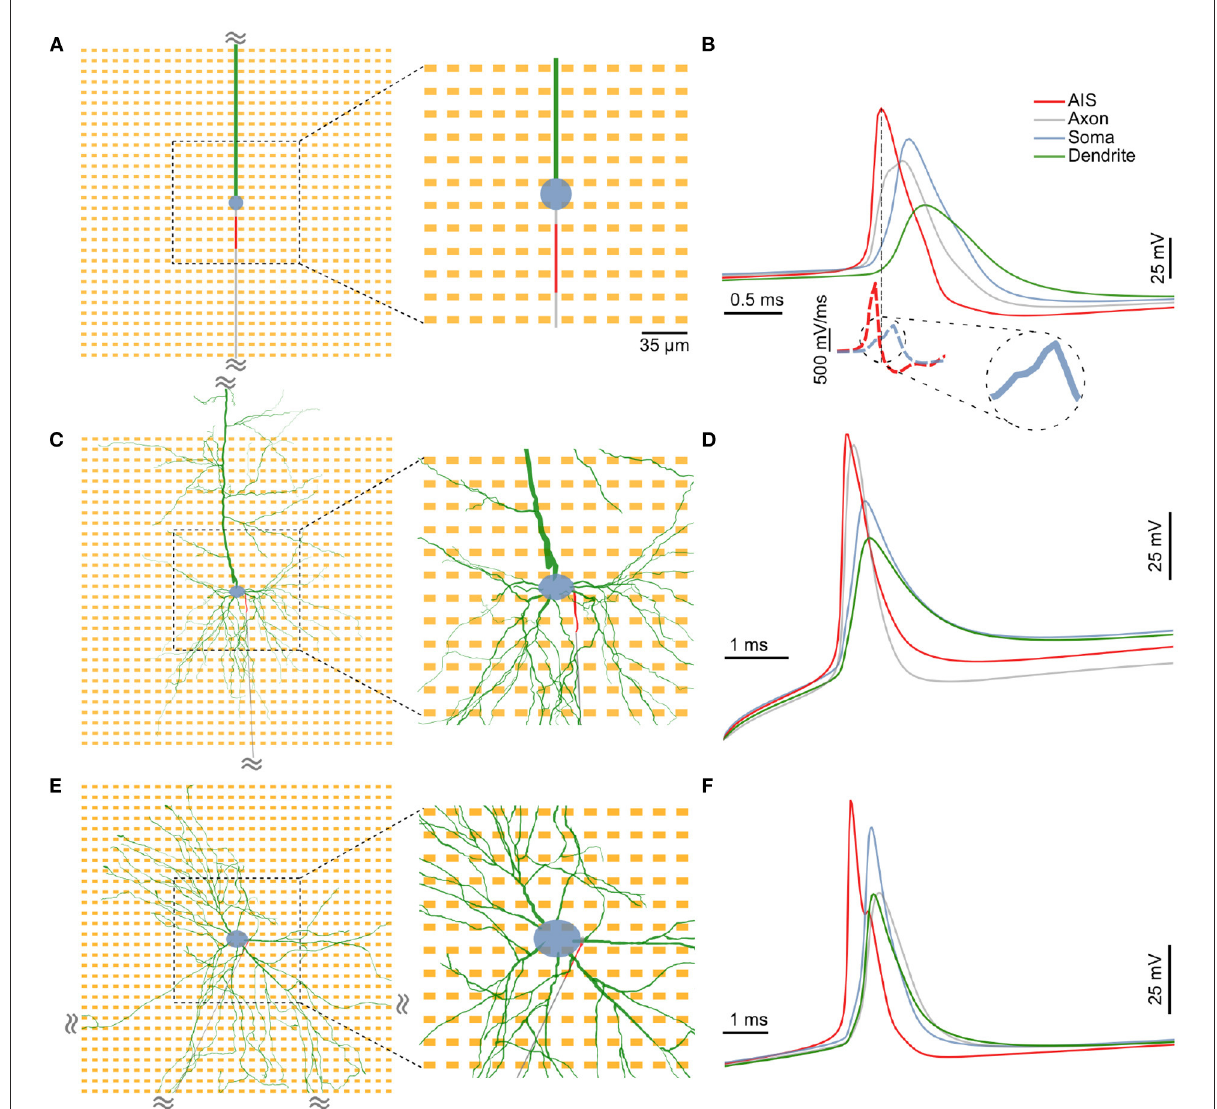
FIGURE1 The three distinct neuron models used in this study: (A) A minimal model consisting of a spherical soma (blue), a long cylindrical dendrite (green) and a cylindrical axon (gray), (C) a detailed neuronal model (DM1) whose morphology was reconstructed from an L5b neocortical rat pyramidal neuron, and (E) another detailed neuronal model (DM2) whose morphology was based on that of a neuron from a in vitro 2D rat primary dissociated cortical culture. In each case, a 30 µ m section of the proximal axon was defined as the axon initial segment (AIS; in red) and was assigned a high density of inactivating sodium and non-inactivating potassium channels. In the extracellular space around each neuron, we simulated a 30 x 30 HD-MEA with an electrode pitch of 17.5 µ m. A 12 x 12 electrode block at the center (zoomed-in region) was chosen for a detailed analysis of extracellular “footprints”, i.e., the extracellular electrical potential landscape of a neuron across electrodes. (B,D,F) In each model, the AIS was the site of spike initiation. Intracellular voltages computed at various locations along the neuron revealed a clear temporal order with the initial peak at the AIS (red), followed by delayed peaks at the distal axon (gray), soma (blue) and the dendrite (green). Moreover, spike shapes at the AIS had a steeper slope during depolarization ( B , lower inset). The somatic AP had a characteristic “kink” at its onset, which is observable as a break in the monotonous rise in the slope of the waveform [ (B) , lower inset, zoomed in].